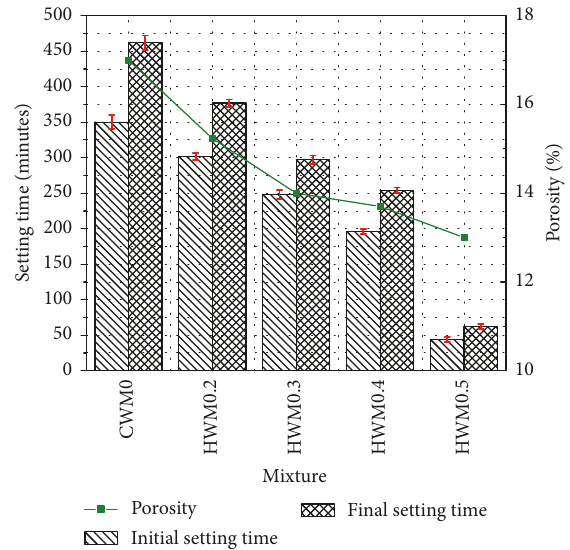
Figure 1: Setting time and 28-day apparent porosity of cement